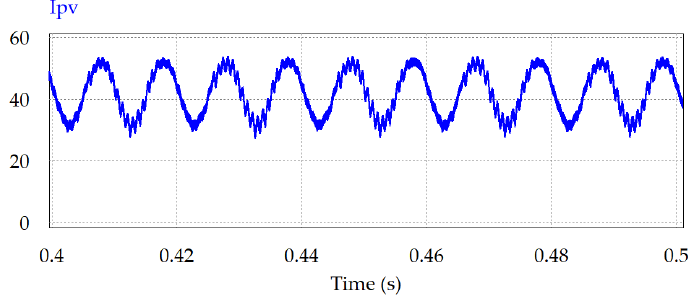
Figure 28. Simulation results of operation mode 6, PV input current I PV